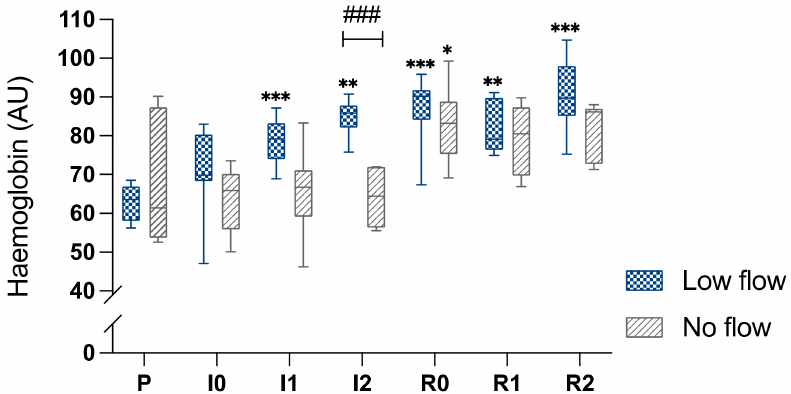
Figure 5. Box-plot diagram of the intestinal haemoglobin measured by MS in arbitrary units (AU) during the different time points. P, pre-ischaemia; I0, immediately after induction of ischaemia; I1, 60 min ischaemia; I2, 120 min ischaemia; R0, immediately following reperfusion; R1, 60 min reperfusion; R2, 120 min reperfusion. Significant differences of the time points compared to pre- ischaemia are marked with an asterisk (* p < 0.05; ** p < 0.01; *** p < 0.001), significant differences between the groups are indicated with a horizontal bar and accompanying hash (### p < 0.001).